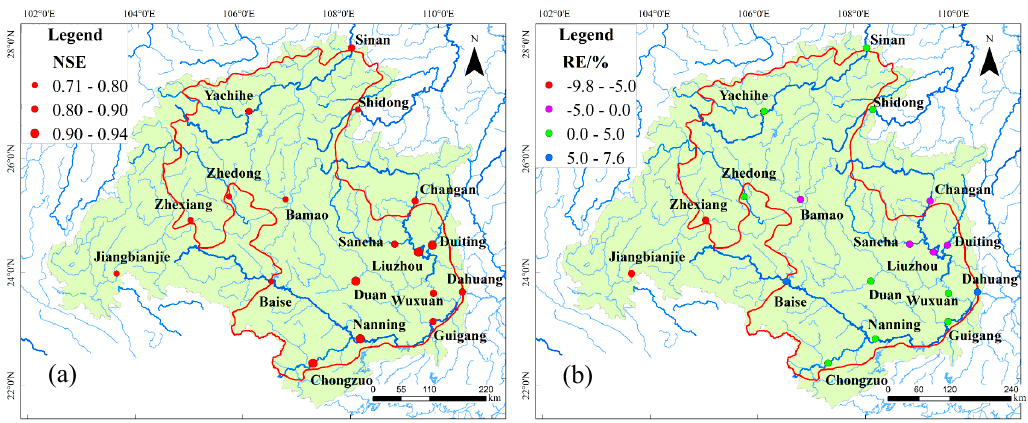
Figure 9. Schematic illustration of model validation results: ( a ) Nash–Sutcliffe efficiency (NSE) and ( b ) Relative error (RE). Table 4. Calibration and validation of simulated monthly discharge at 18 representative hydrological stations.